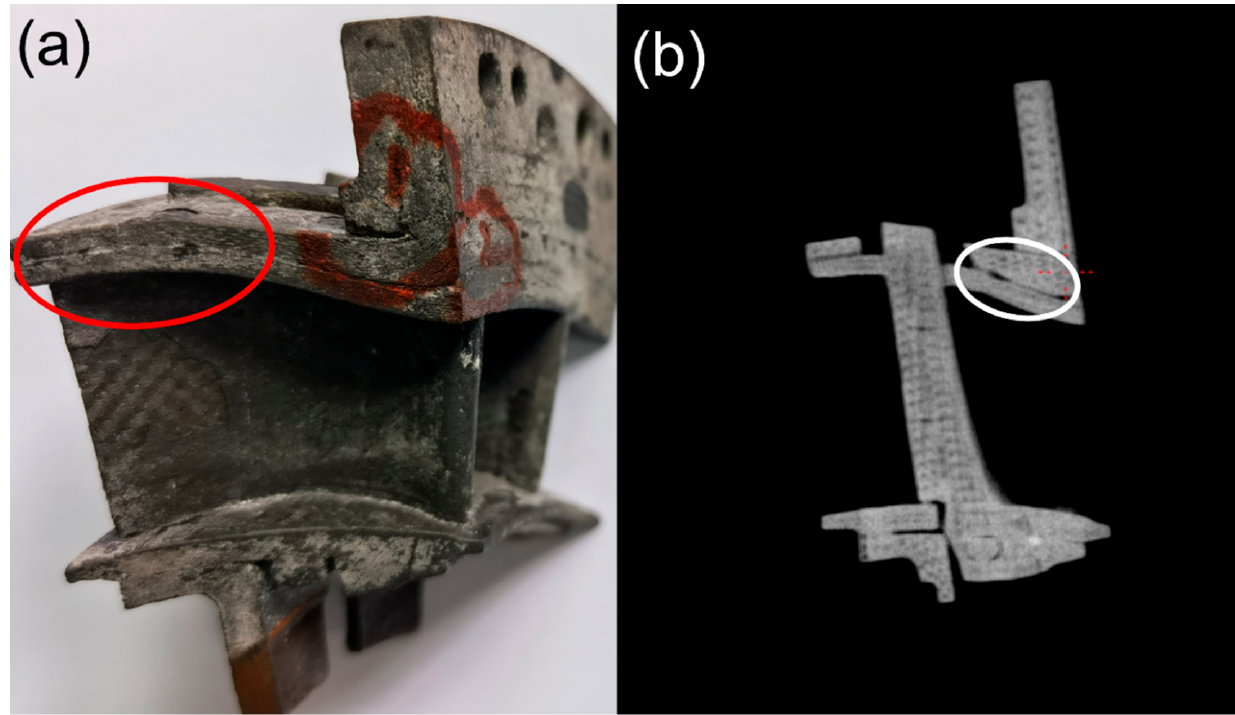
Figure 14. Thermal shock test of SiC/SiC twin guide vane at target temperature of T = 1480 °C at N = 200 ( a ) New delamination occurred at the trailing edge; and ( b ) New delamination observed under XCT.